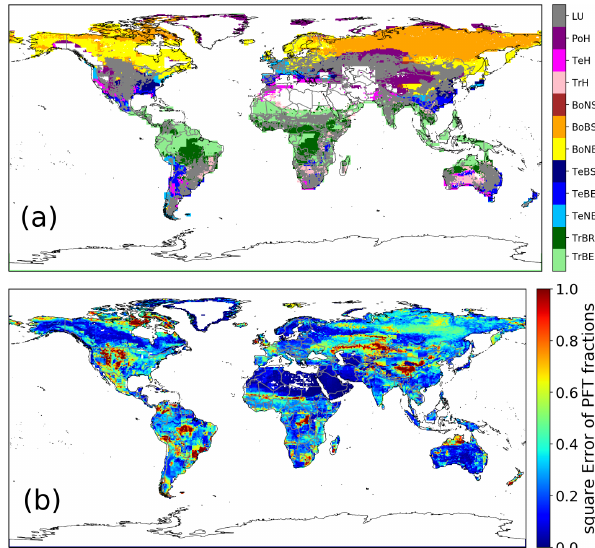
Figure 9. (a) The dominant PFT for each cell, modeled by CM2Mc- LPJmL. Cells with more than 50% land use are masked using gray. Cells with less than 200gCm − 2 are shown using white. Full names of PFTs can be found in Appendix B. (b) The sum of squares errors of ESA CCI land cover for each PFT in each cell. Blue areas have a small error, and red areas have a large error. The error shown here is absolute; hence, areas with a low PFT cover for both model and evaluation data are small compared with areas with a large PFT